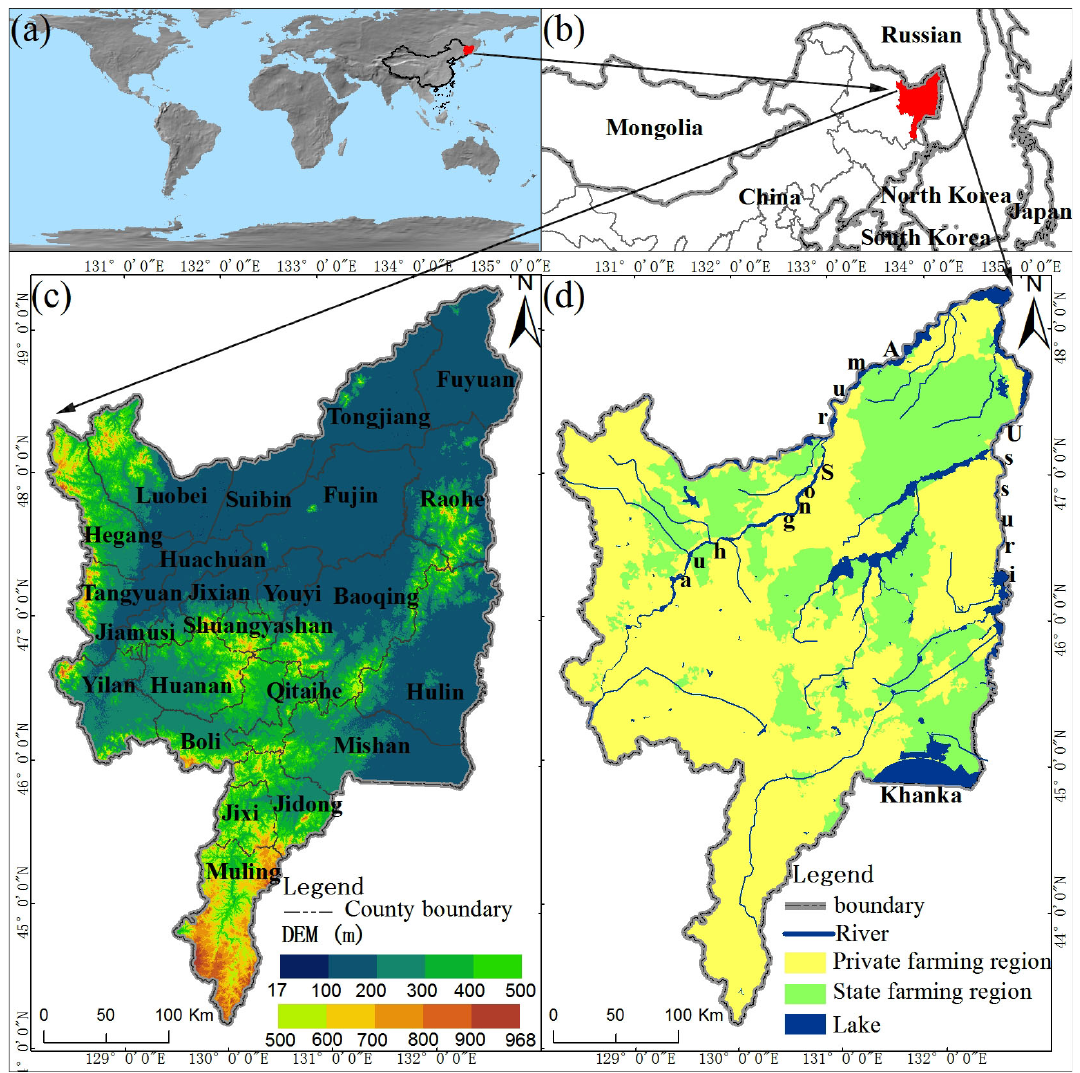
Figure 1. Global and regional scale locations of the study area ( a , b ); digital elevation model (DEM) and county boundaries ( c ); and main water bodies and administrative extent of the state and private farming ( d ).